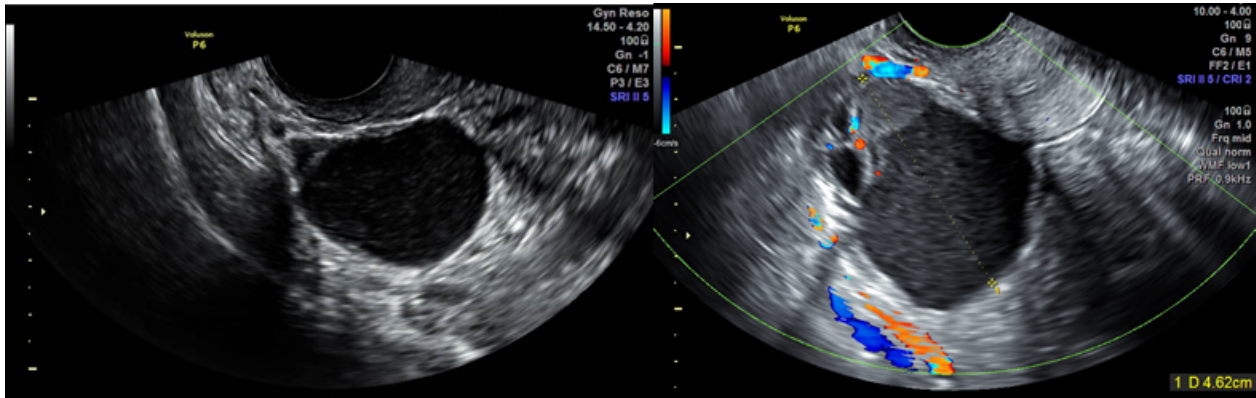
Figure 5. Case number 8; 30 years old woman, presented without symptoms. On TVUS multilocular cyst, hystological result was a mucinous cystadenoma.